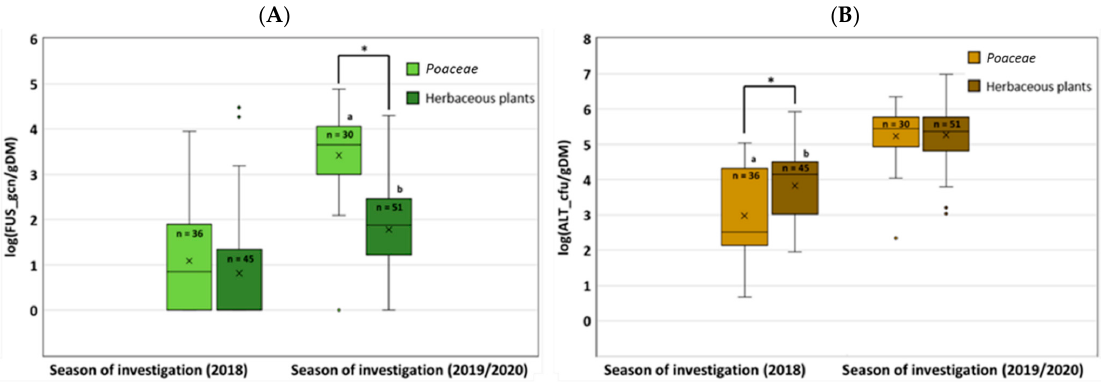
Figure 4. Abundances of Fusarium ( A ) and Alternaria ( B ) fungi expressed as LOG (x + 1) (gene copy numbers) of Fusarium (FUS_gcn/gDM) and Alternaria (ALT_gcn/gDM) on weed plants of the Poaceae family and of herbaceous plants in 2018 and 2019/2020. The different weed plants were sampled at edges of all kettle holes. The midline of the boxplots represents the median; x is the mean value; the upper and lower limits of the boxes are the third and first quartiles. Asterisk brackets indicate significant differences between parameters investigated (* p -values < 0.05; ** is an outlier). a and b highlight that there is a significant difference ( p < 0.05) between the samples to be found.